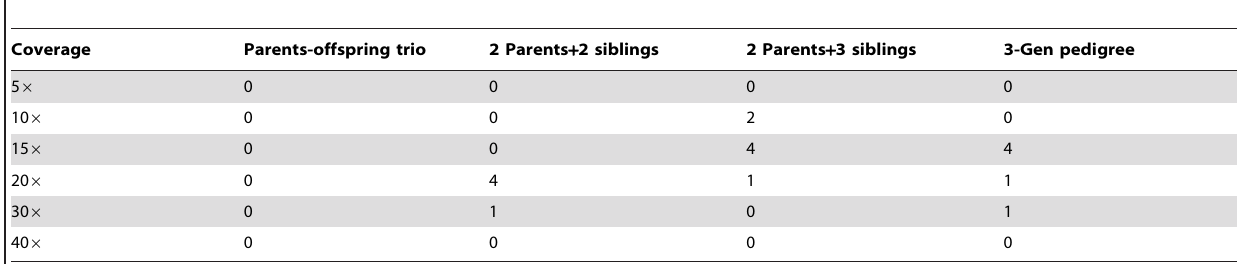
Table 4. Number of false positive de novo mutations per billion bases detected by PolyMutt of jointly modeling for sequencing